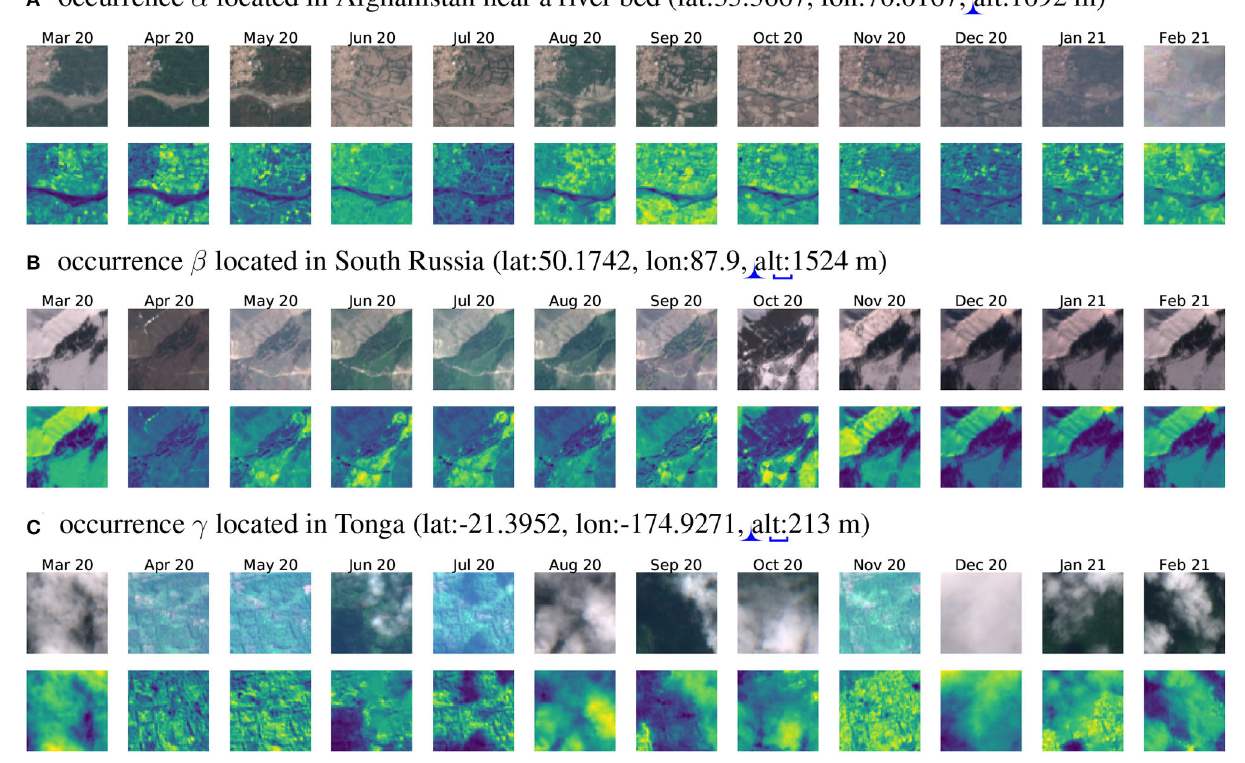
rolling year on Copernicus Open Access Hub. Because of all that constraints, we finally chose a fixed period for all 12-month time series, with a starting date of 1 March 2020 and an ending date of 29 February 2021 (the choice of the recent period being linked to the temporal distribution of the number of occurrences, as shown in Figure 2B